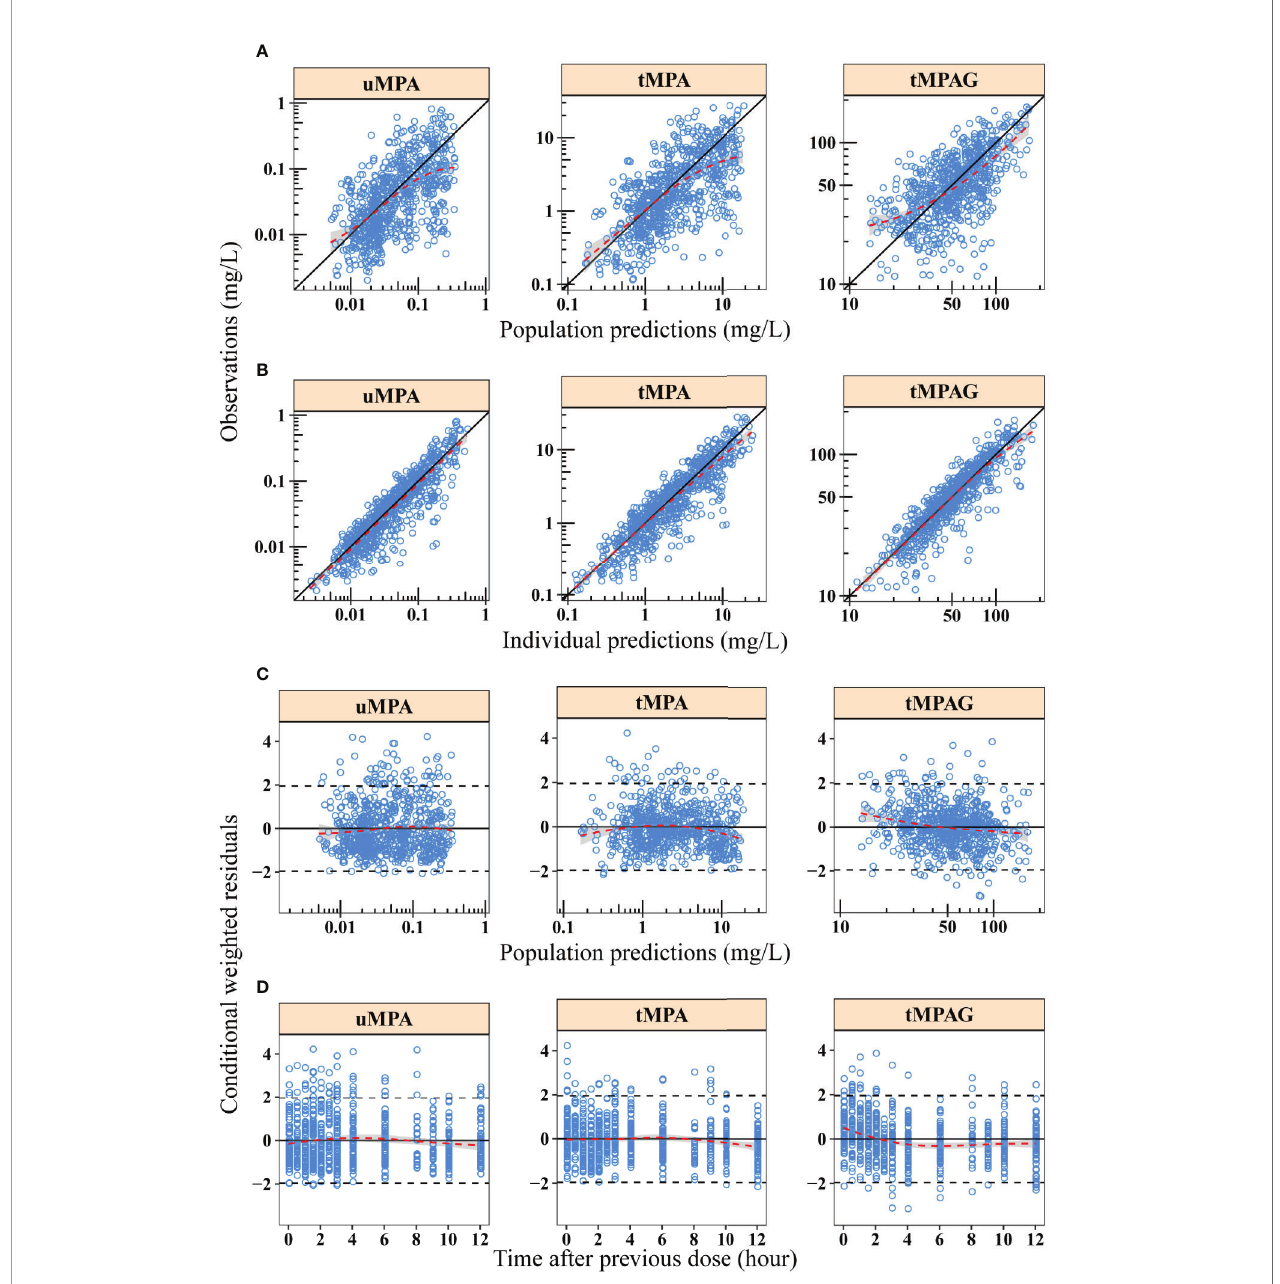
FIGURE 2 | Goodness-of- fi t plots of fi nal model for uMPA, tMPA and tMPAG. (A) Population predictions versus observations; (B) individual predictions versus observations; (C) population predictions versus conditional weighted residuals; (D) time after previous dose versus conditional weighted residuals. Red dashed lines and gray-shaded areas represent the locally weighted regression line and 95% con fi dence interval, respectively. In plots A and B, black solid lines represent the line of unity. In plots C and D, black solid and dashed lines represent the y = 0 and y = ± 1.96 reference lines, respectively. tMPA, total mycophenolic acid (MPA); tMPAG, total 7-O-mycophenolic acid glucuronide; uMPA, unbound